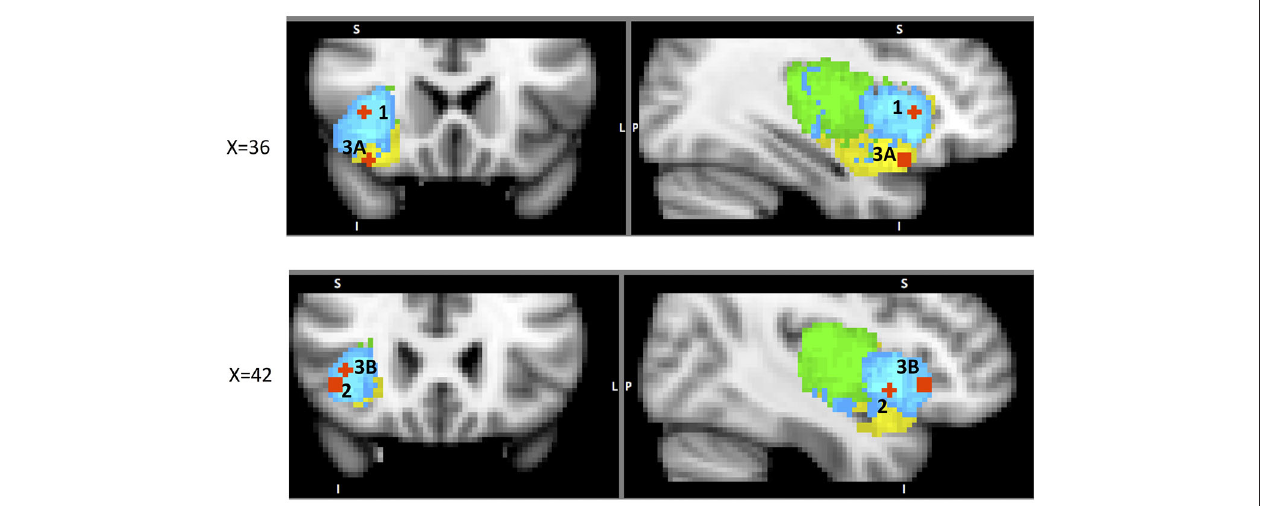
FIGURE 4 | A sample of studies addressing the IC’s role in Action Phase (for illustration purposes only). Sub-regions of the Insula: posterior (green), dorsal anterior (blue) and ventral anterior (yellow). IC activation related to 1 – when to act in Jenkins et al. (2000) (38, 22, 2); 2 – what action to choose in Mueller et al.